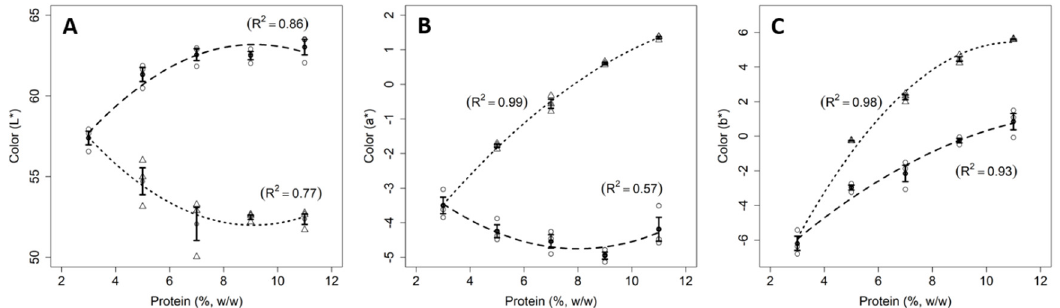
Figure 3. Relationship between color parameters and protein concentrations for skimmed milk (dashed line) and mixed protein (dotted line) samples. The figure shows the data points for milk (circles) and mixed samples (triangles), error bars (SE), fitted curves, and adjusted coefficients of determination (R 2 ). The parameters L* represents lightness ( A ), a* red (+), and green ( − ) components ( B ), and b* yellow (+) and blue ( − ) components ( C ).